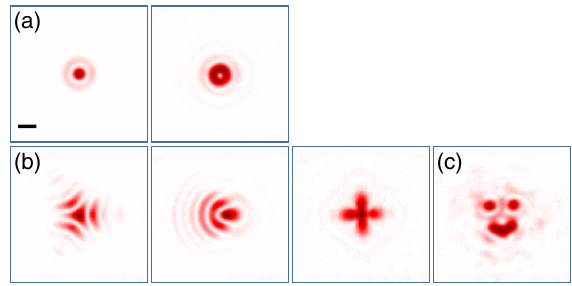
FIG. 5. Measured target intensities with the CMOS (scale bar 33 μ m) in the conjugate plane before being demagnified ( 5 ×) to the IP. (a) Concave and convex lens. (b) Programmable intensity modulation. (c)